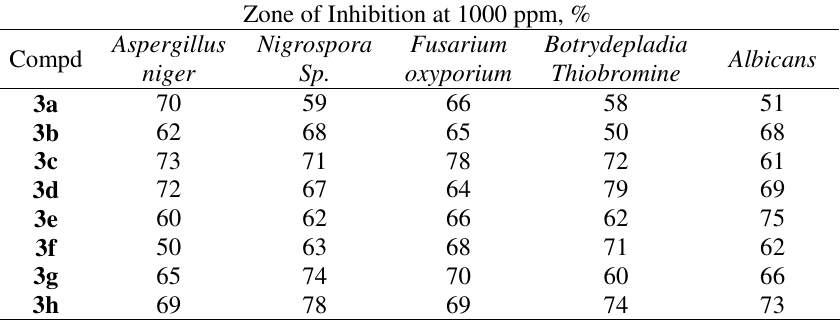
Table 4. Antifungal activity of compounds ( 3a-h ). Zone of Inhibition at 1000 ppm,